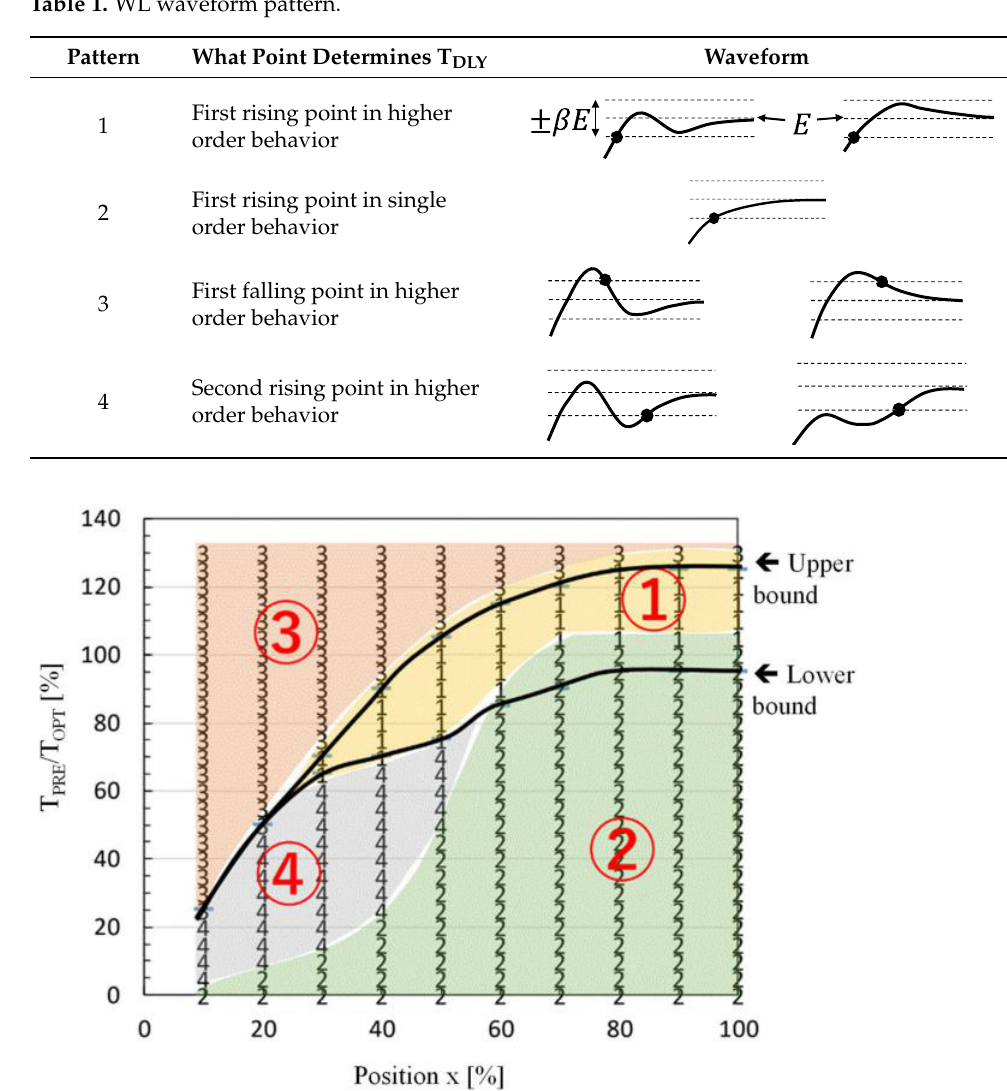
Figure 3. WL waveform pattern across x and T PRE . 1–4 areas in the figure indicate pattern 1–4 in Table 1,